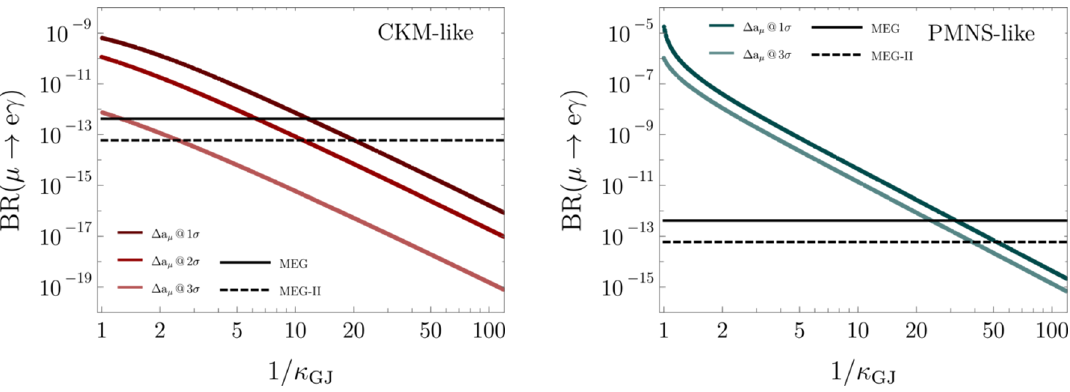
Figure 4 . Variation BR( (cid:22) ! e (cid:13) ) with k GJ for some representatives points that reproduce (cid:1) a (cid:22) at di(cid:11)erent levels of accuracy when k GJ = 1. The black continuous (dashed) line signals the current (future) limit from MEG (MEG-II) [102,